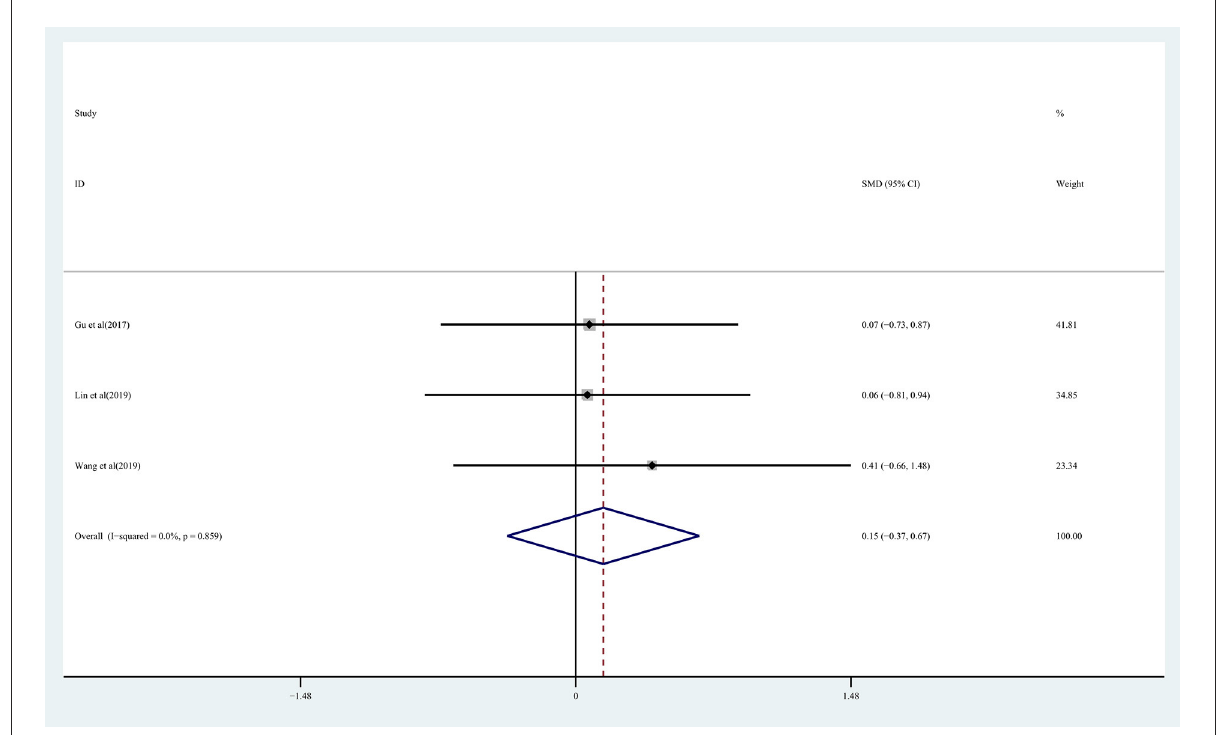
FIGURE4 Forest plot of the effect of rTMS treatment on lower extremity function recovery in chronic stroke patients.